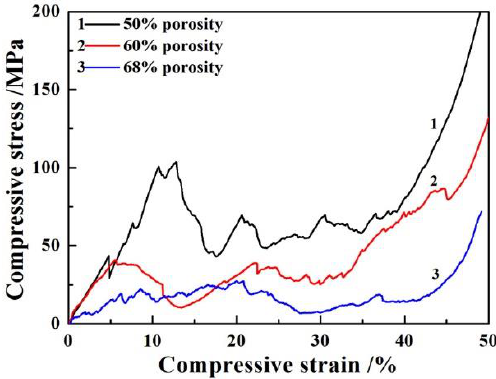
Figure 6. Compressive stress-strain curves of as-sprayed porous Mo deposits with different porosities.